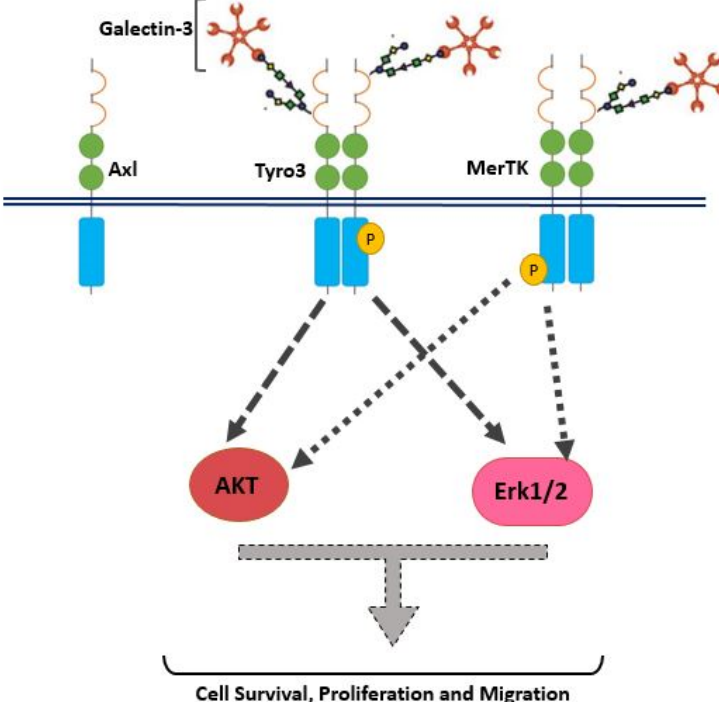
Figure 9 . Schematic of Gal-3 as an agonist for Tyro3 in human cancer cells. Gal-3, represented here in its pentameric form as has been reported, stimulates Tyro3 phosphorylation and activation, as well as downstream activation of Erk and Akt signal transduction pathways, which drive cell proliferation and survival/migration, respectively. The illustration of Gal-3 binding directly to a glycosyl chain on Tyro3 is a proposed model of Gal-3 agonistic action and requires investigation.